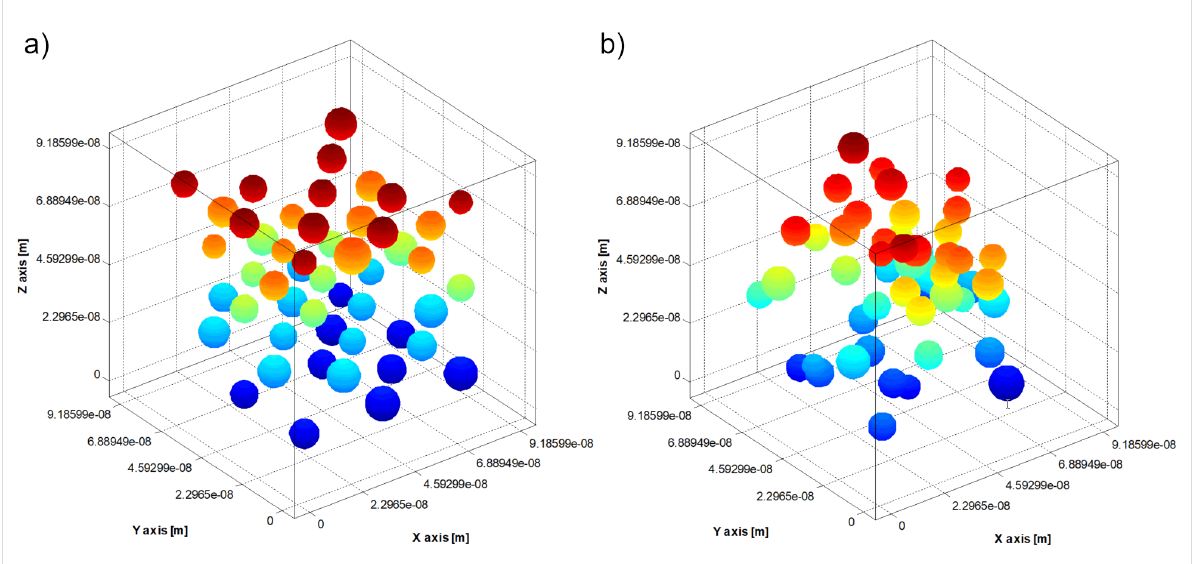
Figure 2: Positions of nanoparticles inside the test cube: a) initial moment; b) after 0.1 ms (thickness of the coating layer = 1 nm, polymer surface density ξ = 4.5•10 17 m − 2 ).